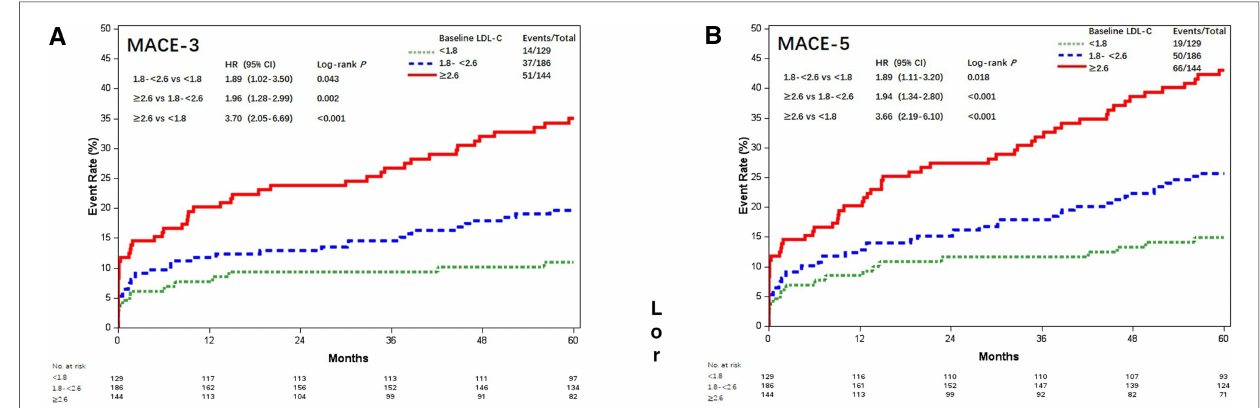
FIGURE 3 Kaplan – Meier curves of MACE-4 and MACE-5 among different postoperative LDL-C levels (mmol/L). Kaplan – Meier estimates for freedom from ( A ) MACE-3 and ( B ) MACE-5. LDL-C, low-density lipoprotein cholesterol; MACE-4, 4-point major adverse cardiovascular events; MACE-3, 3-point major adverse cardiovascular events; MACE-5, 5-point major adverse cardiovascular events.